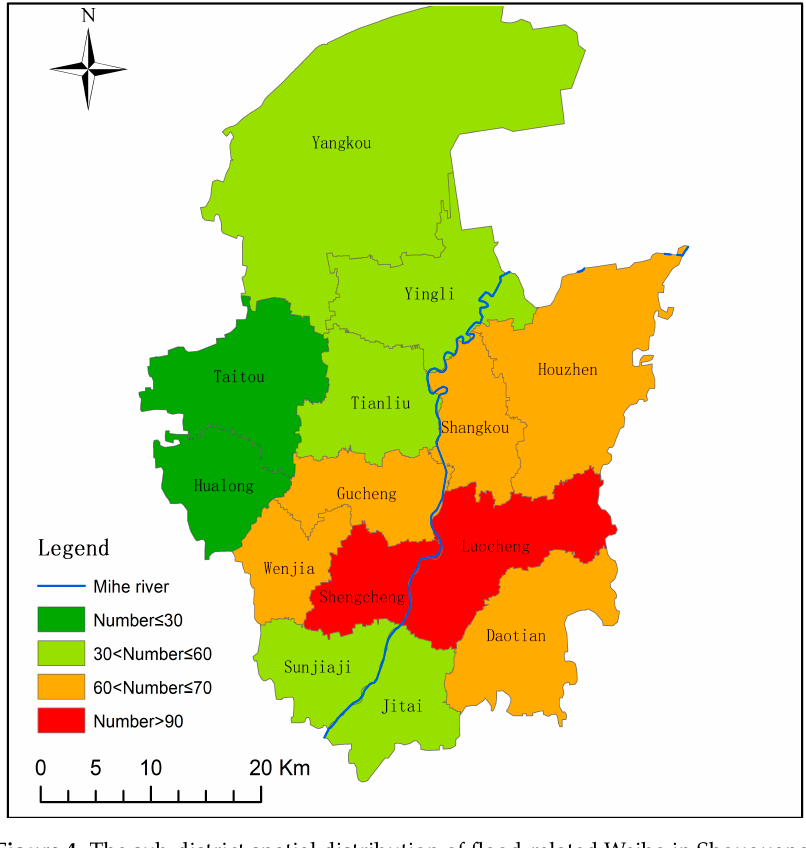
ISPRS Int. J. Geo-Inf. 2019 , 8 , x FOR PEER REVIEW Figure 4. The sub-district spatial distribution of flood-related Weibo in Shouguang.